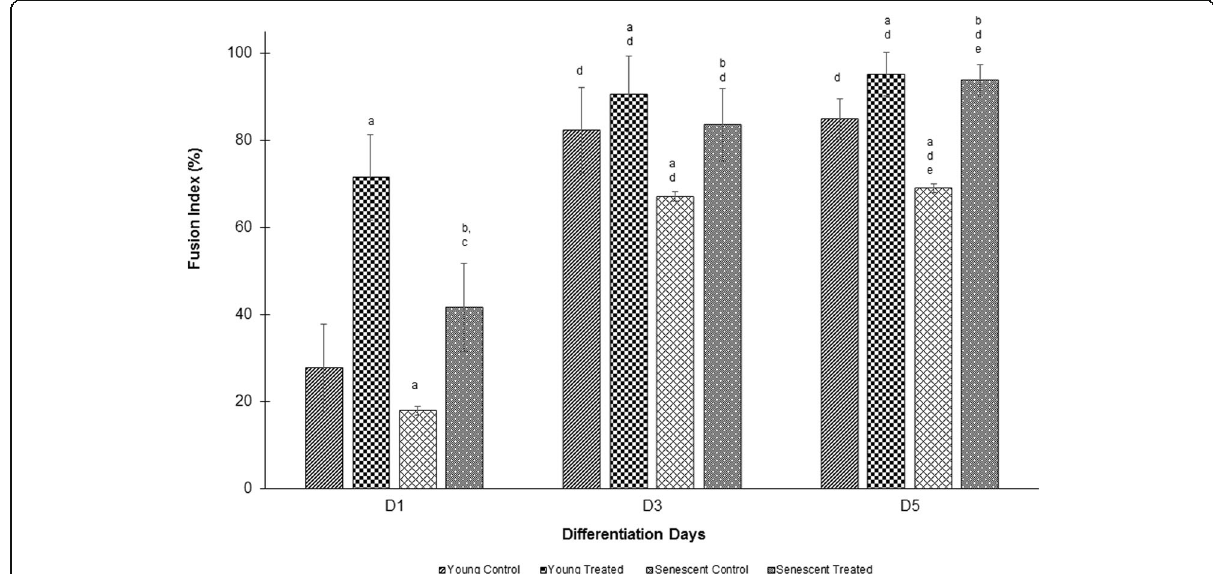
Fig. 2 Effect of TRF on myoblasts differentiation. Fusion index was measured as an index of differentiation. a Denotes p < 0.05 compared to young control, b p < 0.05 compared to senescent control, c p < 0.05 compared to young treated, d p < 0.05 compared to day 1 of the same treatment and e p < 0.05 compared to day 3 of the same treatment. Data are presented as mean ± SD, n = 3